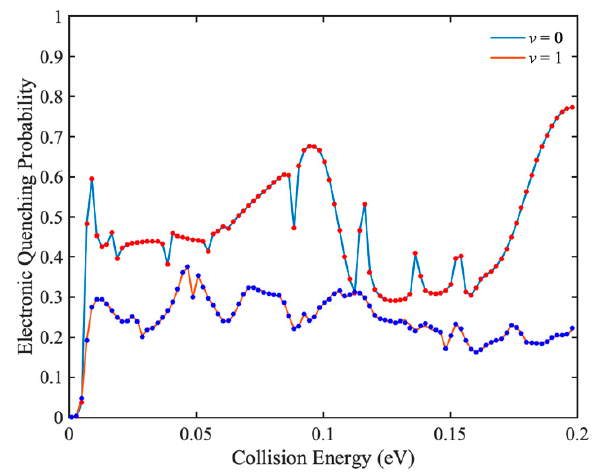
Figure 4. Total electronic quenching probabilities of Na(3p) + H 2 ( v = 0, 1) → Na(3s) + H 2 collisions, and solid and dot lines are obtained by IALR-WP method and L-shaped method, respectively.